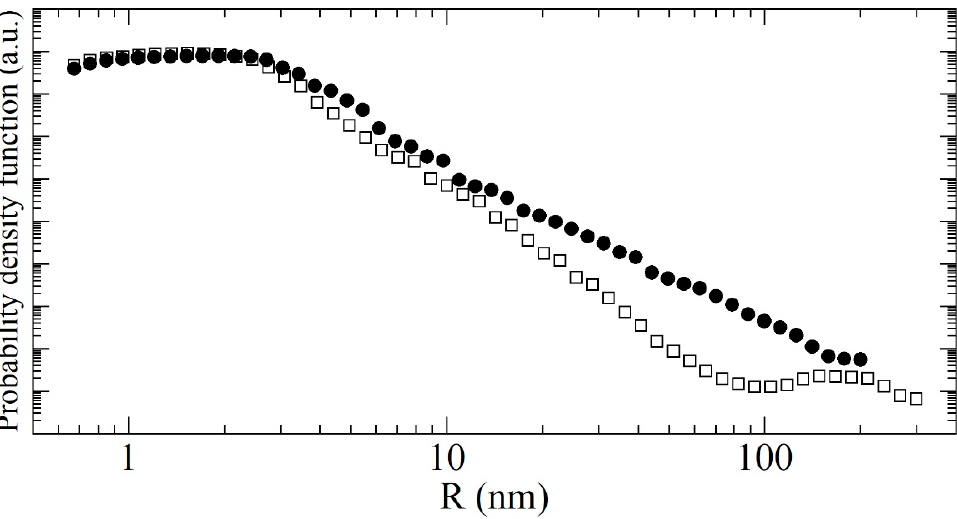
Figure 8. The probability density versus radius (in nm) calculated with the discrete-sized diamond nanospheres model for the F-DNDs (solid circles) and DF-DNDs (open squares). Points correspond to the results of calculation.